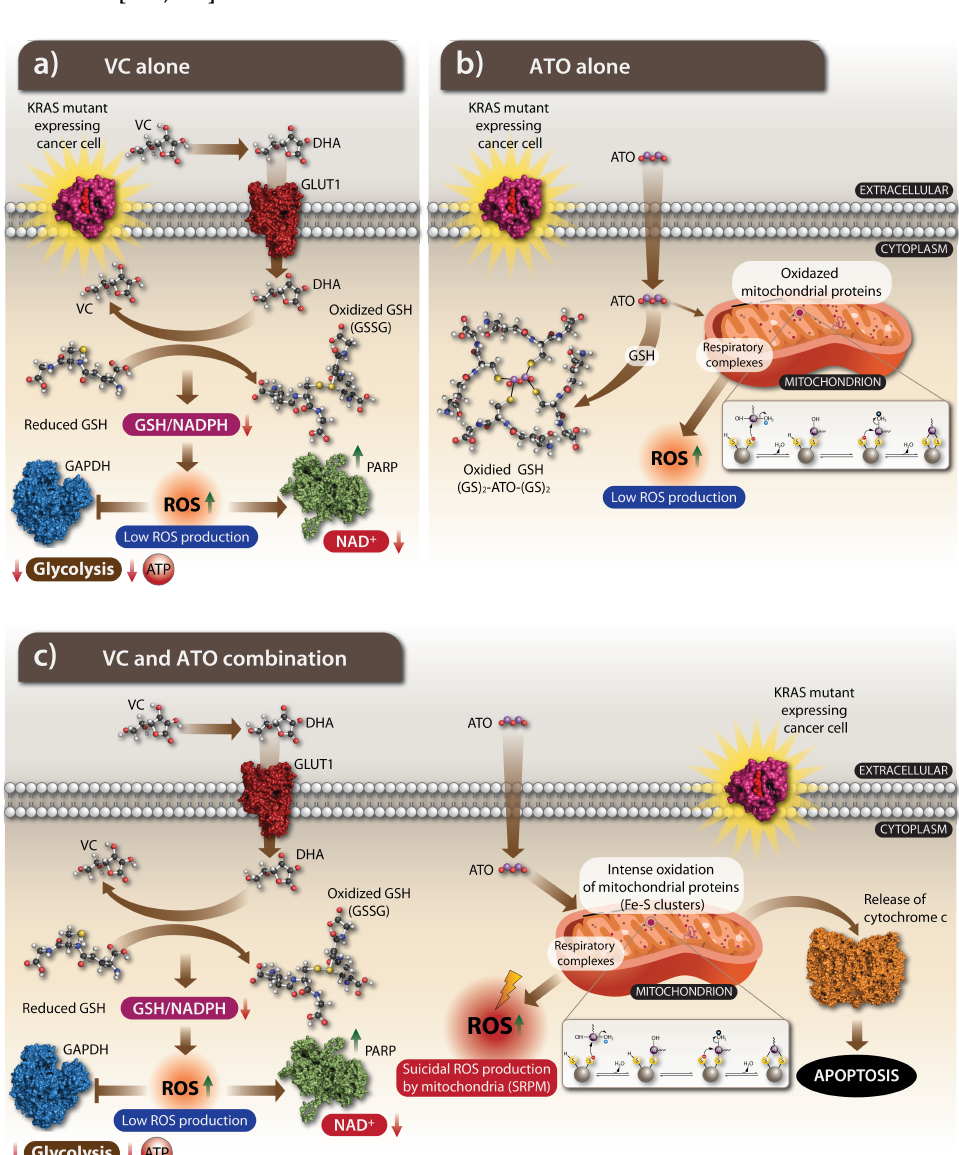
Figure 6. The cellular mechanism of VC, ATO and their co-treatment. ( a ) Increased uptake of DHA through GLUT1 causes oxidative stress as intracellular DHA is reduced to VC, depleting the pool of reduced GSH. This leads to oxidative stress with increased ROS production. The accumulation of ROS inactivates GAPDH, which in turn, in highly glycolytic KRAS-mutant cancer cells, leads to